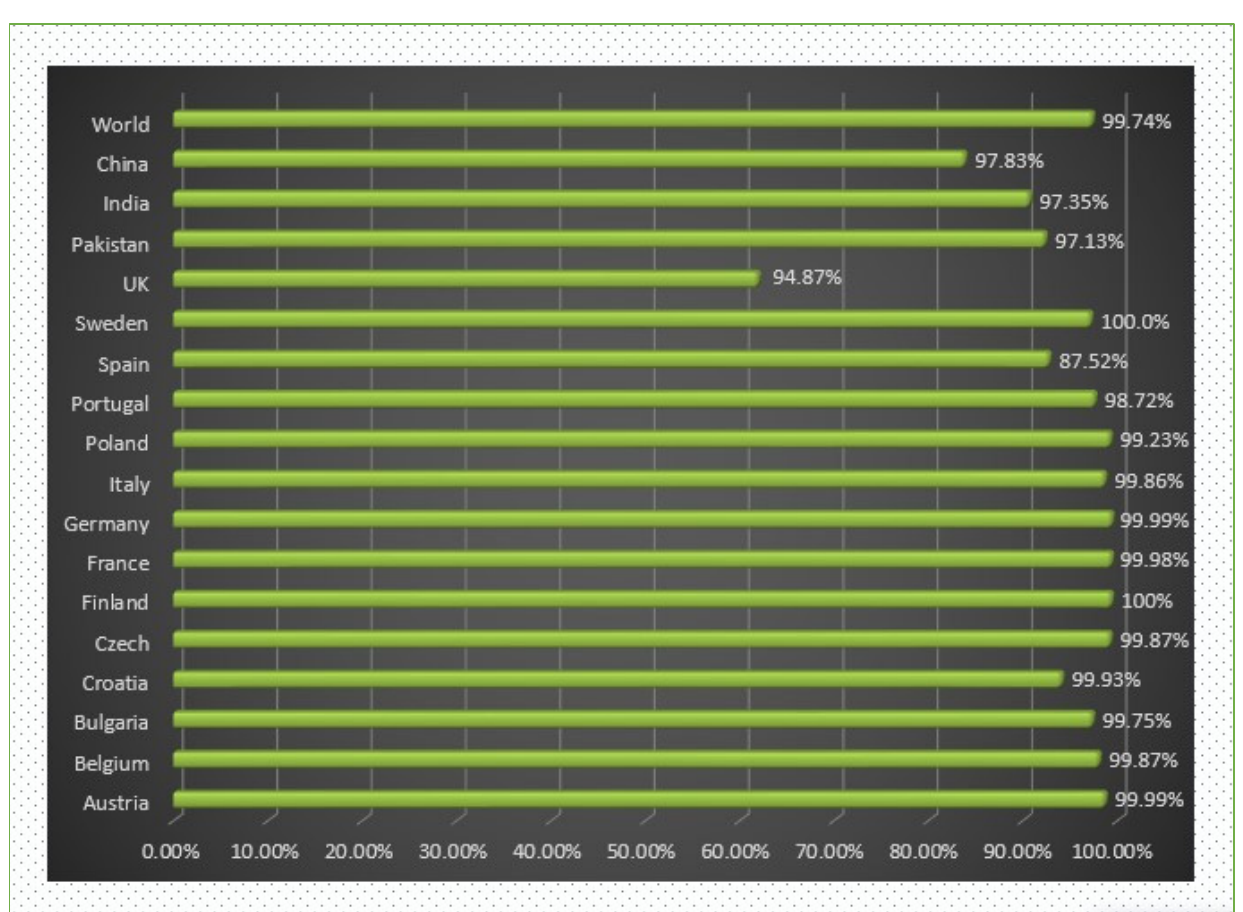
Figure 4. World- and different country-wise population coverage.